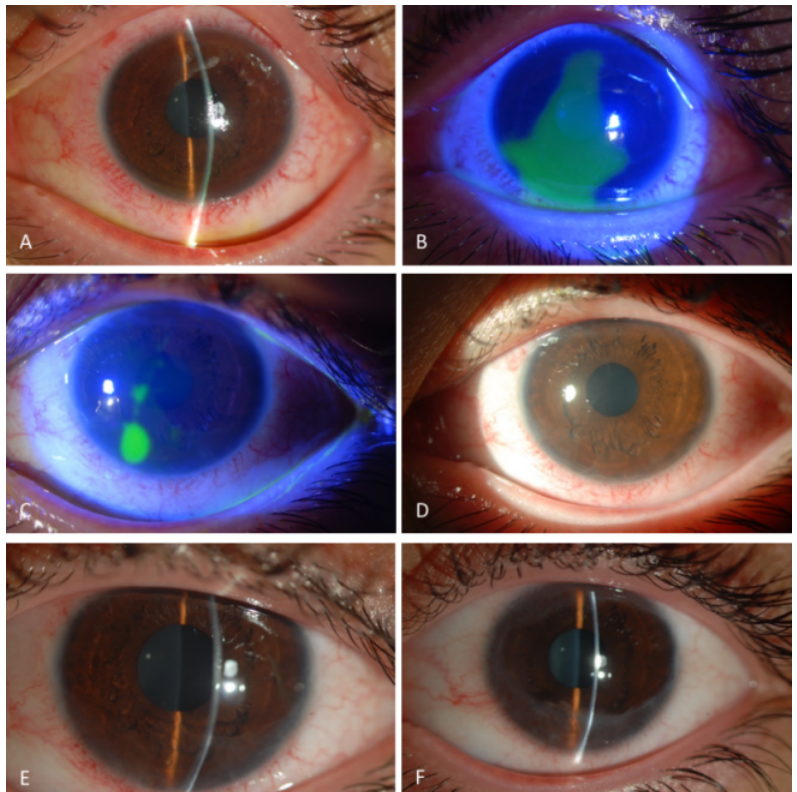
Figure 2: (A,B): Total conjunctival and two third of the corneal epithelial healing, a week after the RGTA treatment. (C,D): Significant reduction in the size of the epithelial defect, at the end of the second week. (E): Complete healing on the corneal surface with mild irregularity of the peripheral corneal epithelium, on day 20. (F): A month after the complete healing, approximately 300º conjunctivalization is seen at the peripheral